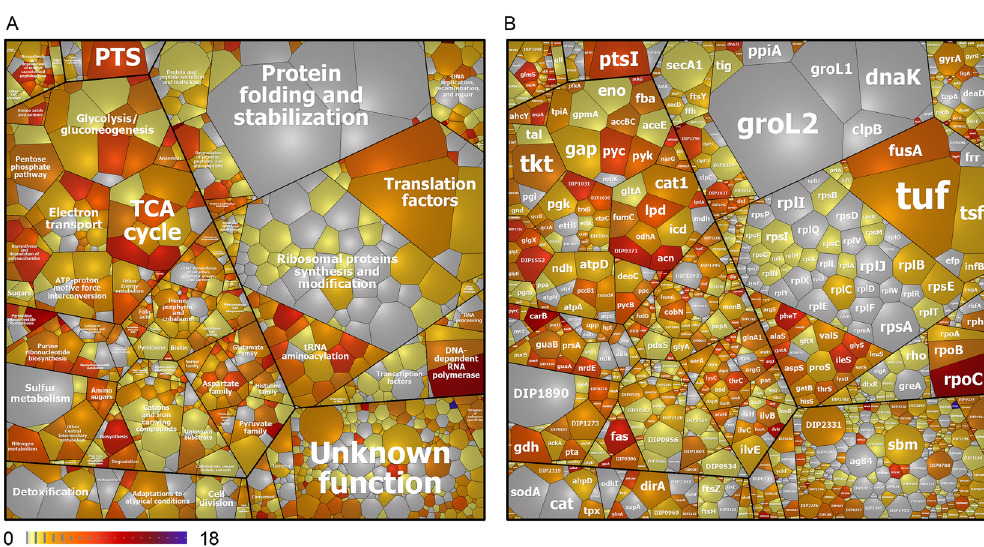
Figure 3. The total Cys abundance treemap of C . diphtheriae with proteins color-coded according to their number of Cys residues. (A) The treemap legend shows the functional classification of 1030 proteins detected in the proteome of C . diphtheriae as revealed by their TIGRfam annotations. (B) The spectral protein abundance determines the cell size of each protein identified in the total proteome ( Table S3 ) . The 805 Cys proteins were color-coded using a yellow-red color gradient based on their numbers of Cys residues. Non-Cys proteins are displayed in grey. The Cys abundance treemap visualizes that C . diphtheriae contains many Cys-rich proteins with > 4 Cys residues in the proteome. The most abundant S -mycothiolated proteins Gap, DirA (AhpC), Ndh and GuaB contribute with 0.4–0.8% to the total Cys proteome. The values of calculated Cys abundances are shown in Table